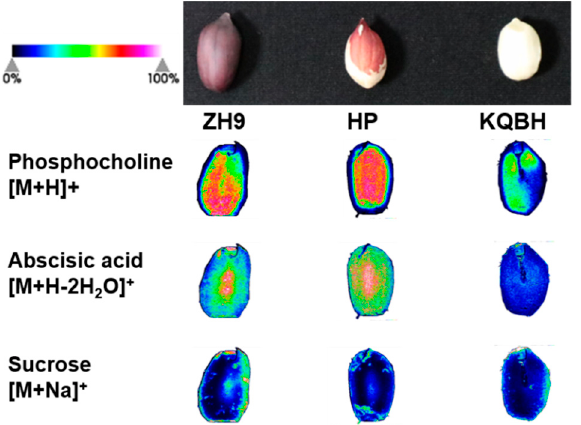
Figure 6. MALDI-MSI of key metabolites in different peanut seeds. The green (minimum) to red (maximum) scale indicates ion intensity corresponding to each metabolite determined by mass spectrometry.